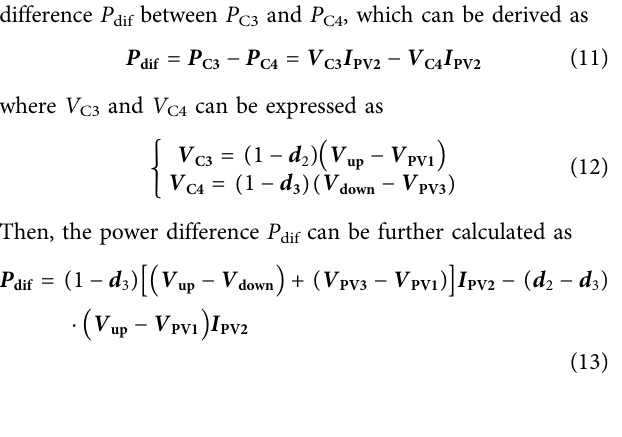
Frontiers in Energy Research |